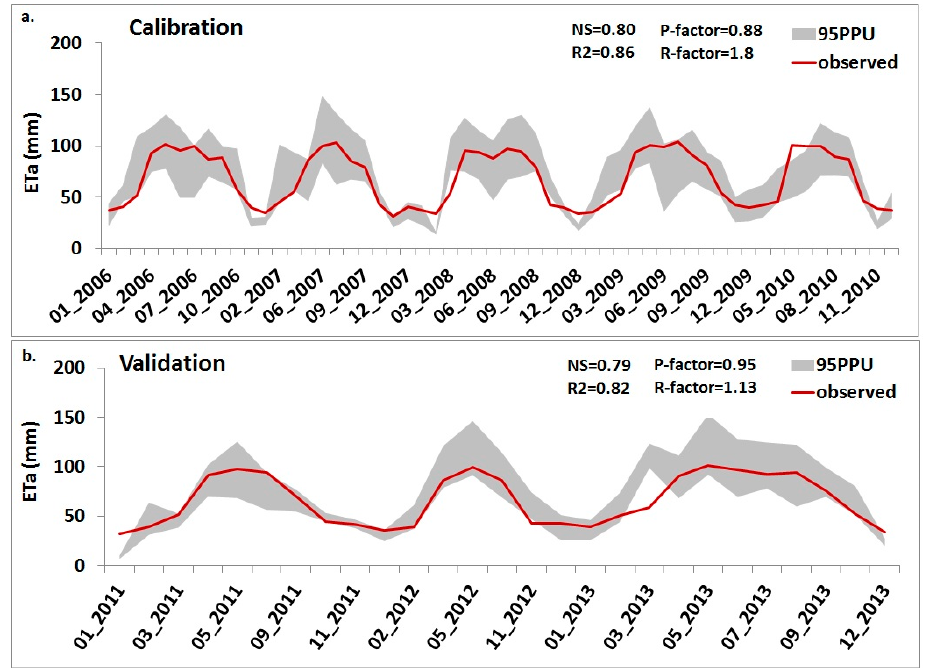
Figure 8. Results of calibration ( a ) and validation ( b ) of ETa using MODIS data.